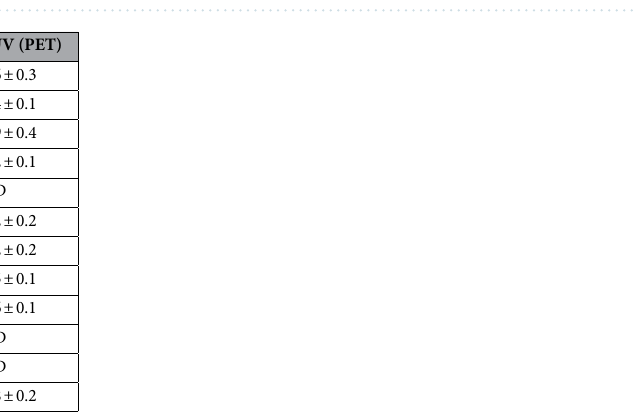
Figure 5. TACs of selected organs following i.v. injection of [ 11 C]MeQ (left, n = 3), and [ 18 F]FEtQ (right, n = 7) into male SD rats. Insets: distribution kinetics in the kidneys. Results are presented as mean ± SEM. Representative PET/CT of coronal ( A , D ), axial ( B , E ), and sagittal ( C , F ) slice images obtained following i.v. injection of [ 11 C]MeQ ( A – C ) and [ 18 F]FEtQ ( D – F ) into male SD rats. Images represent the summation of 15–25 min frames.